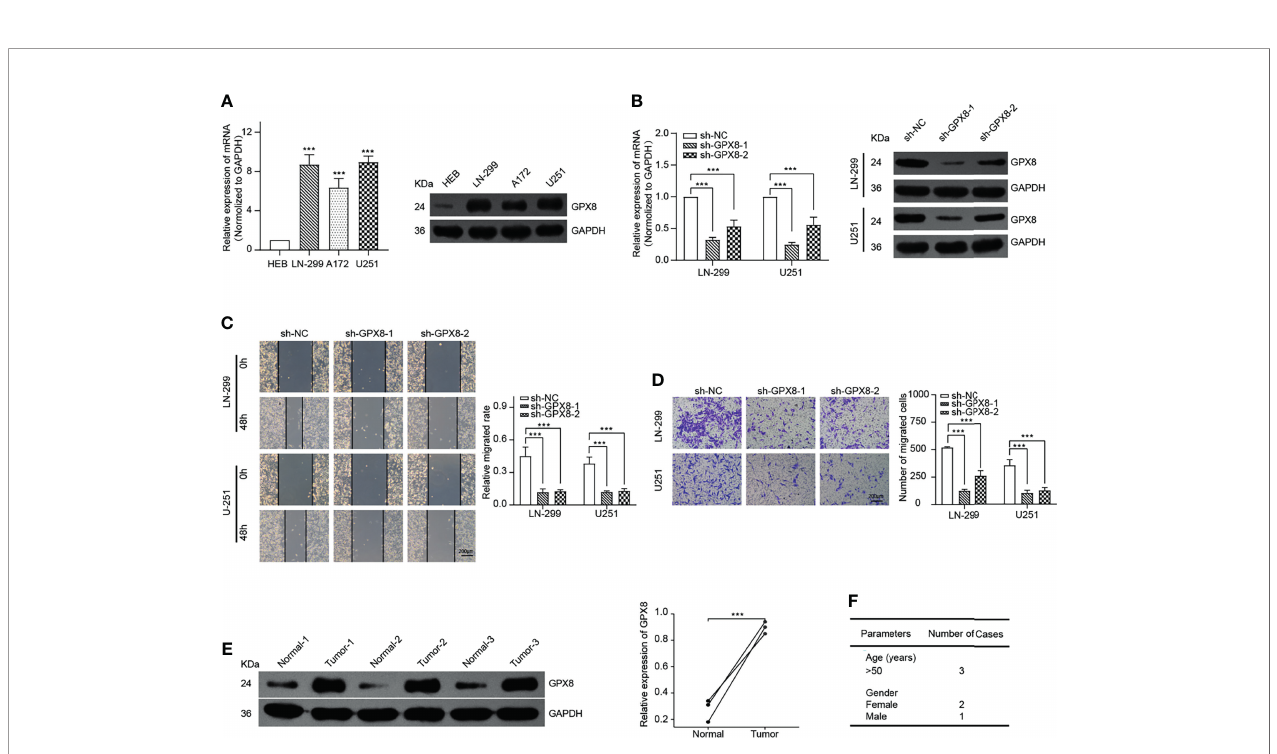
FIGURE 8 | GPX8 is up-regulated in GBM cells and related to migration and invasion in vitro . (A) qRT-PCR and WB con fi rmed the expression of GPX8 was higher in GBM cells. (B) qRT-PCR and WB veri fi ed the ef fi ciency of sh-RNAs. (C) Wound-healing assays indicated the knockdown of GPX8 could restrain the migration of GBM cells. (D) Transwell assays showed the knockdown of GPX8 could inhibit the invasion of GBM cells. (E) . WB con fi rmed the expression of GPX8 was higher in GBM tumor tissues than paracancerous ones. (F) The clinical parameters of the patients. Data were presented as mean ± SD. *** P <